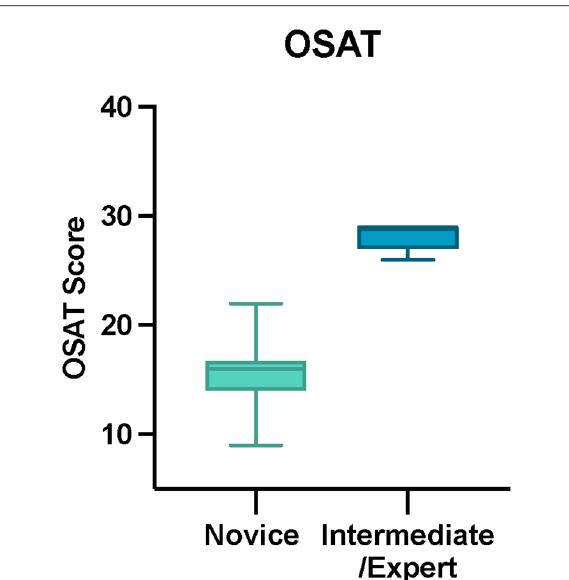
FIGURE 5 Total OSAT score for novice and intermediate and expert participants. The horizontal solid line in the middle of the box is the median value of the scores and the lower and upper boundaries indicate the 25th and 75th percentiles, respectively. The largest and smallest observed values are shown; lines (whiskers) are drawn from the ends of the box to those